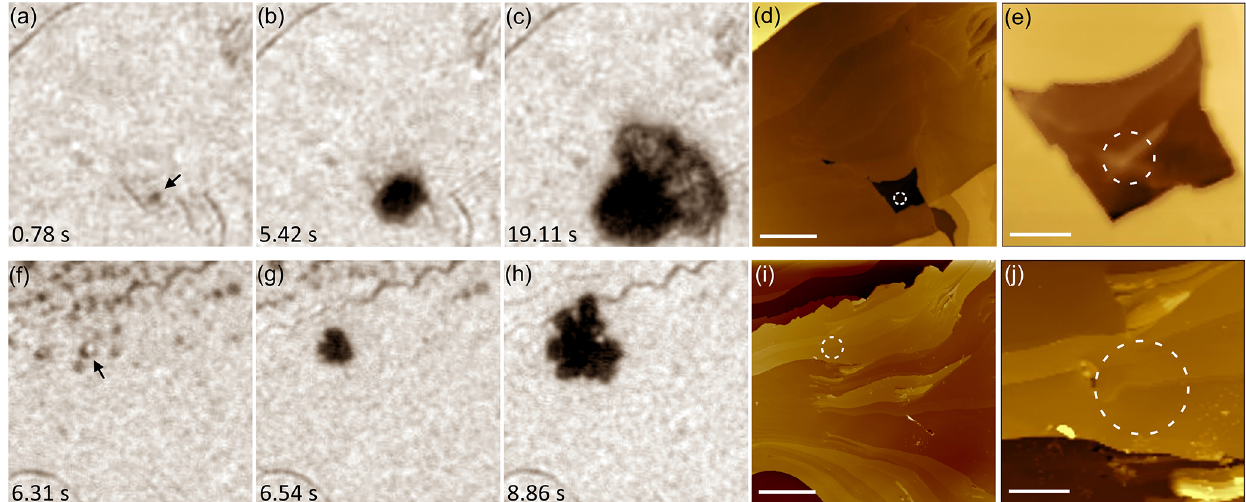
Figure 2. Colocating isolated nucleation events at − 29 . 5 ± 0 . 5 ◦ C to AFM topography. (a–c) Three frames of an ice crystal nucleating and growing under AH in = 0 . 40 ± 0 . 08gm − 3 . (d) AFM image of the same location in (a) – (c) with dashed circle around the area of nucleation. Scale bar 20µm. (e) Expanded view of a portion of (d) showing a small protrusion within a larger pit. Scale bar 5µm. (f–h) Frames taken under AH in = 0 . 48 ± 0 . 08gm − 3 which show a collection of droplets on the surface in (f) . The arrow points to the droplet which initiates an ice crystal. (i) AFM of the same area as in (f) – (h) with a circle around the original droplet in (f) . Scale bar 20µm. (j) Expanded view of (i) . Scale bar 5µm. Time stamps in lower left corner of optical frames are relative to the start time of their respective movies; however the time when water vapor fills the cell is not measured with significant precision. Accompanying videos can be found in Friddle and Thürmer (2019b).